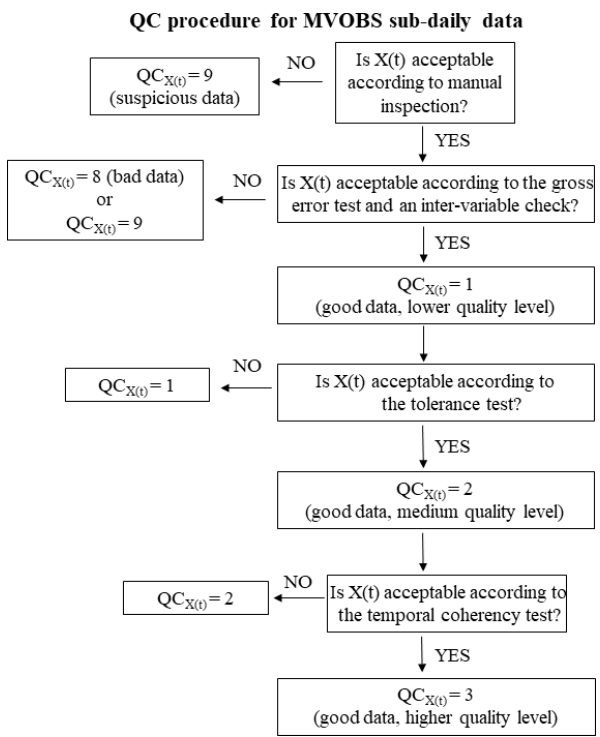
Figure 5. A schematic of the QC strategy developed in this study to check the observation of a determined parameter X collected at the time t . It should be highlighted that the cloud cover parameter underwent only the gross error test, and the temporal coherency test has not been applied to precipitation data (accumulated rainfall and